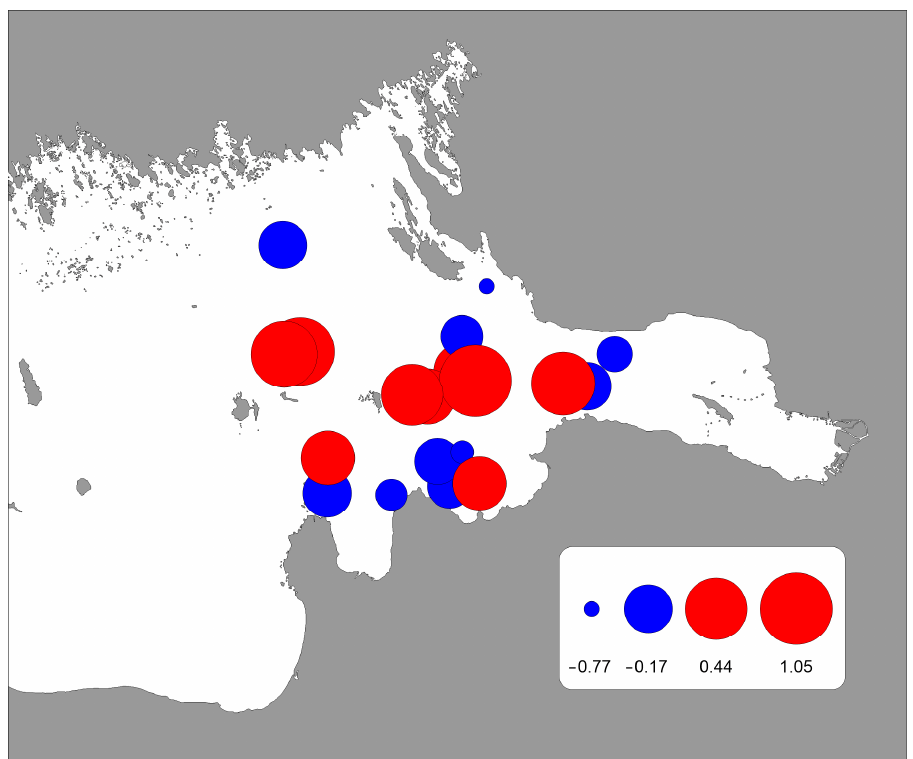
Figure 3. Sediment Pollution Index (SP) at sampling sites in the eastern Gulf of Finland. Blue and red cycles denote, respectively, negative and positive anomalies of this index.